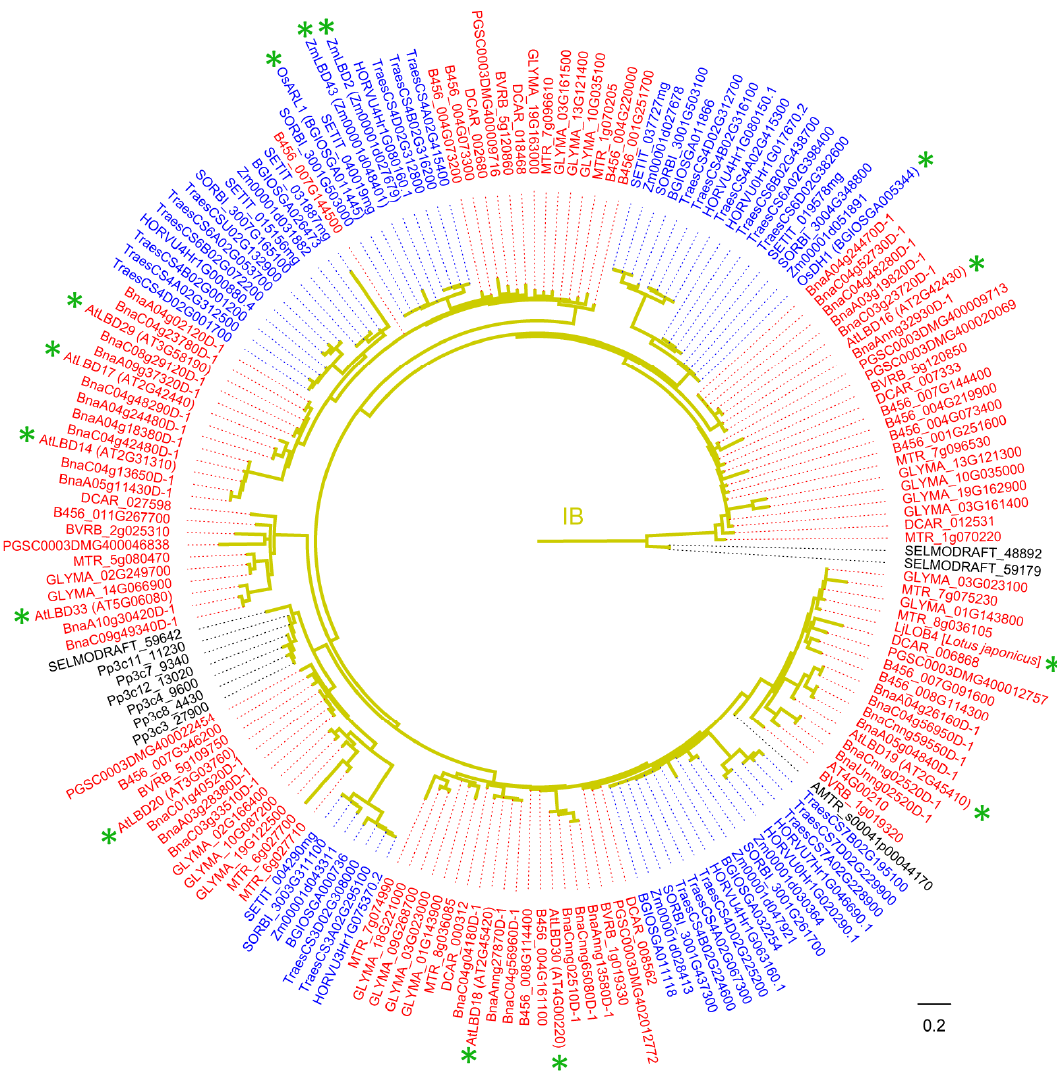
Figure 4. Phylogeny of LBD proteins from Class IB in 18 species. This phylogeny was reconstructed using Class IB LBD proteins identified in Figure 1 and according to the same method described in Figure 1 legend. “*” means functionally characterized LBD protein in Table 2 (Gene ID is in brackets for LBD proteins of 18 species, species name is in square brackets for LBD proteins of other species). LBD proteins of eudicots, monocots, and other plant species are marked in red, blue and black, respectively. Branch color corresponds to that in Figure